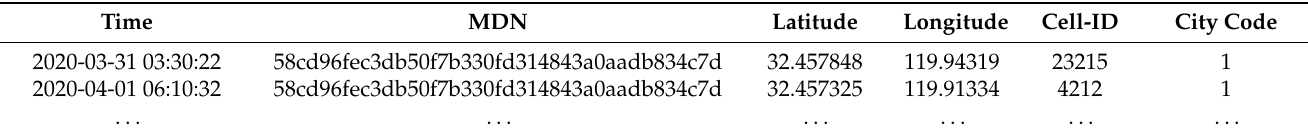
Table 1. Examples of the MSD (the MDNs are